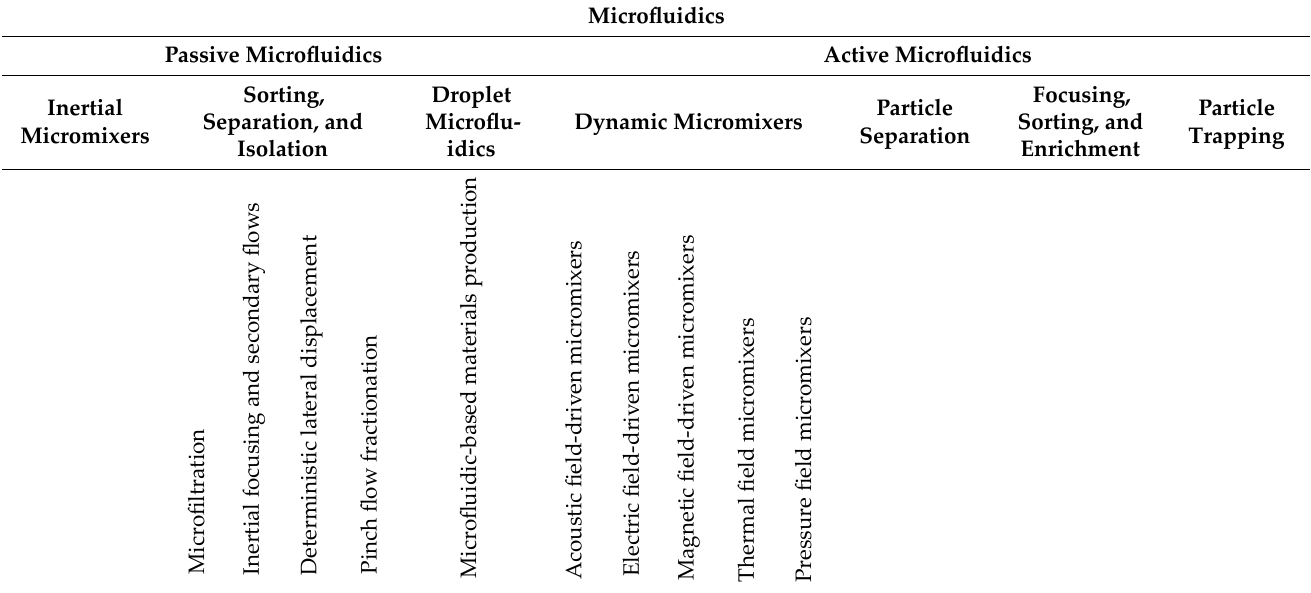
Table 1. Summary of passive and active